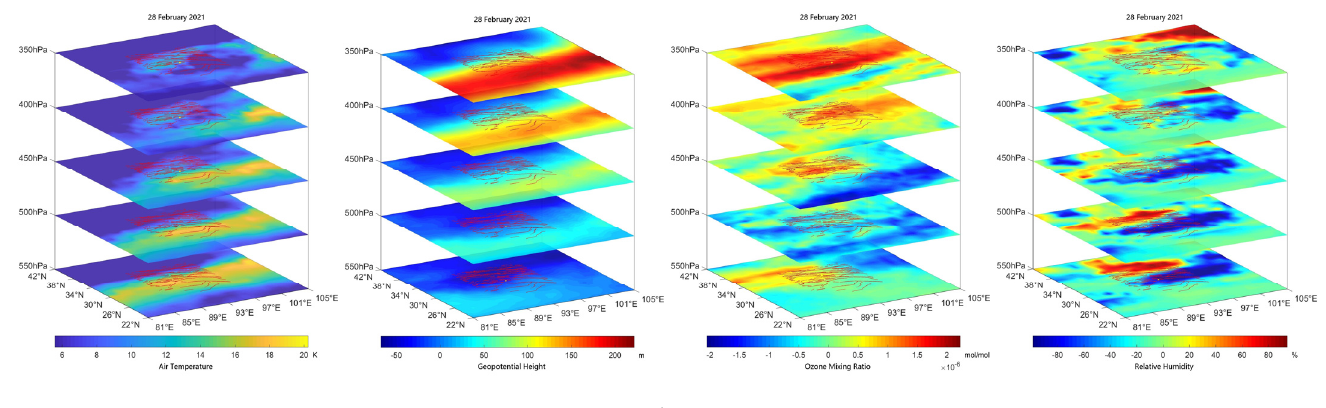
Figure A2. Composite atmospheric anomaly maps during atmospheric thermal anomalies associated with earthquake in Biru on ( a ) 21 February; ( b ) 22 February; ( c ) 23 February; ( d ) 24 February; ( e ) 25 February; ( f ) 26 February; ( g ) 27 February; ( h ) 28 February, 2021. The epicenter and faults are shown by yellow point and red lines, respectively. For each row, the subplots represent air temperature, geopotential height, ozone mixing ratio and relative humidity from left to right.